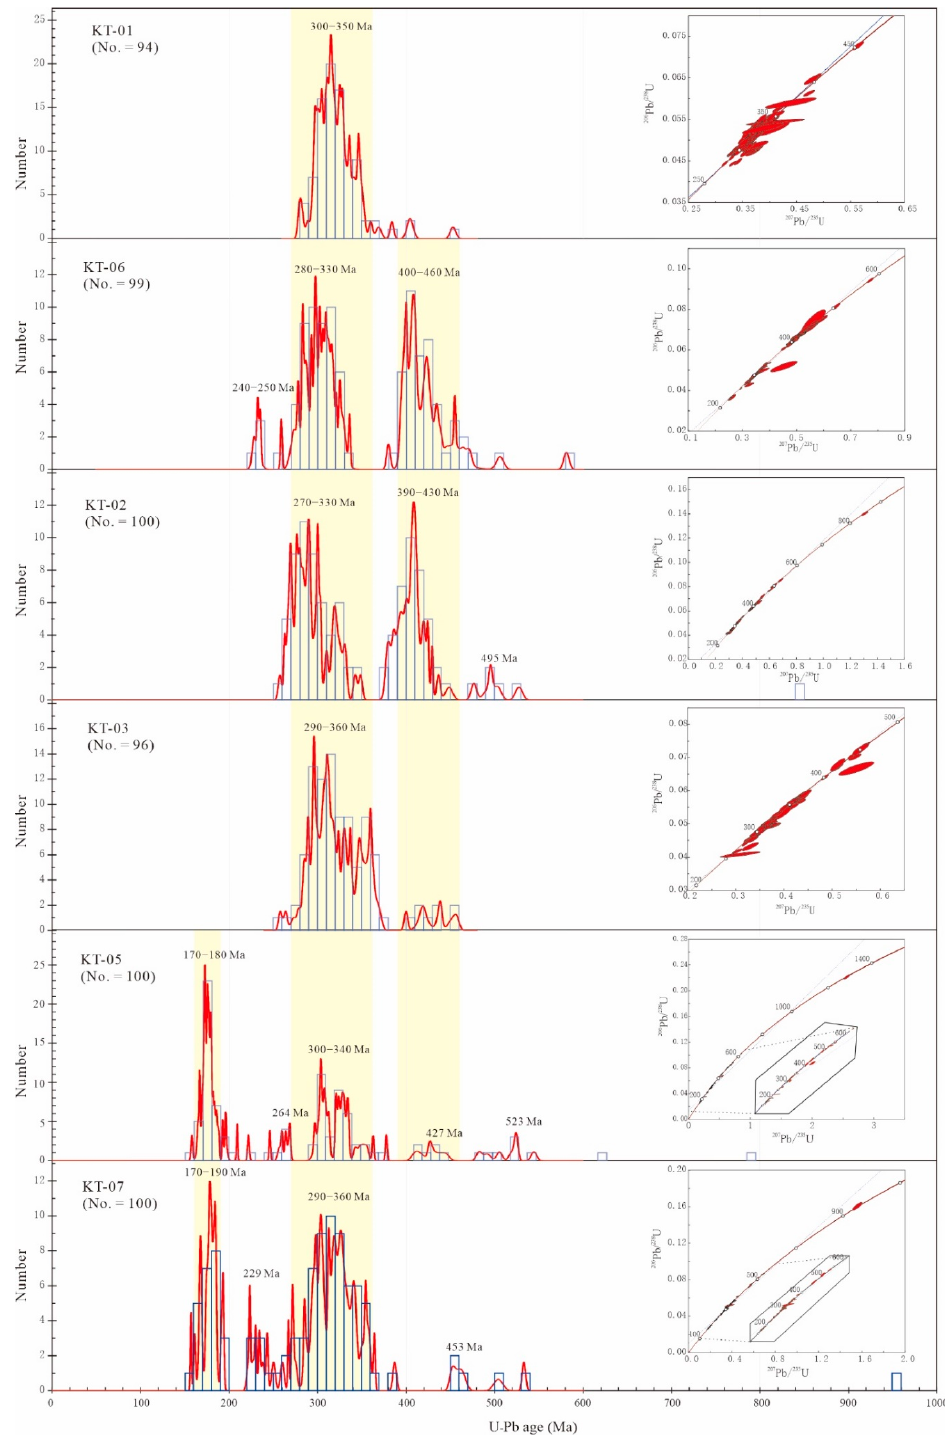
Figure 9. Detrital zircon U-Pb age concordia and frequency distribution diagrams.